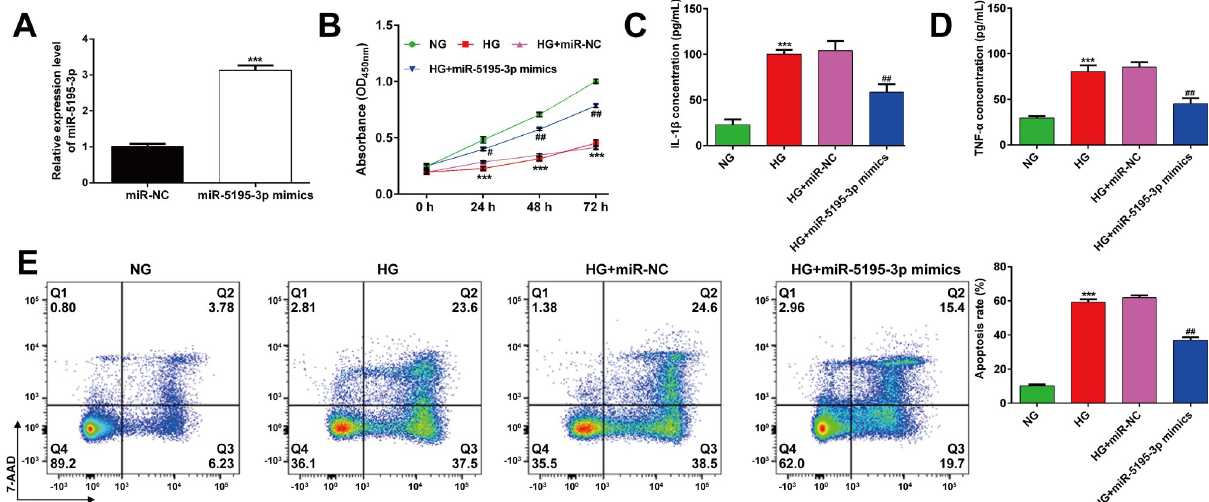
Fig 2. Effects of miR-5195-3p overexpression on ARPE-19 cell viability, inflammation and apoptosis after HG stimulation. (A) Analysis of reverse transcription quantitative PCR was conducted to evaluate miR-5195-3p expression in ARPE-19 cells transfected with miR-5195-3p mimics or miR-NC. ��� p < 0.001, compared with miR-NC; (B) The transfected ARPE-19 cells were exposed to HG, followed by CCK-8 assay. ELISA assay was performed to analyze the release of IL-1 β (C) and TNF- α (D) in transfected ARPE-19 cells, followed by HG stimulation. (E) The percentages of apoptotic cells were compared in transfected ARPE-19 cells, followed by HG stimulation. Data were shown as mean ± SD. ��� p < 0.001 compared with NG; # p < 0.05, ## p < 0.01, compared with HG + miR-NC; NC, negative control; HG, high glucose; NG, normal glucose.